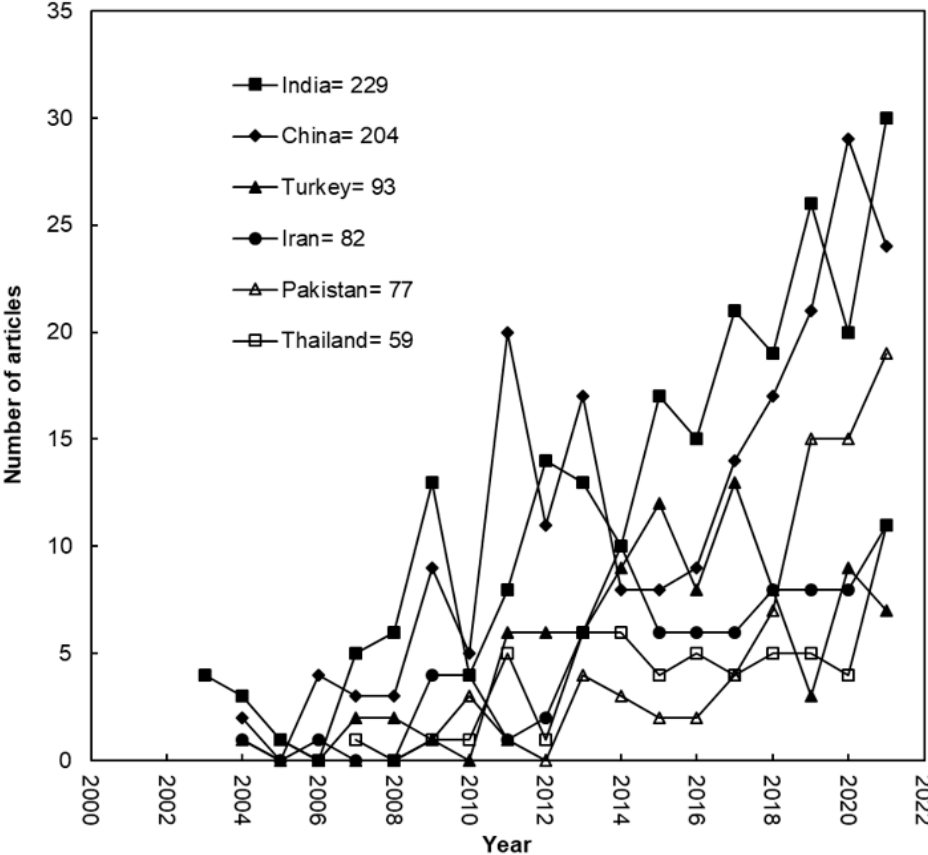
Figure 3. Comparison of development trends among the top six productive countries.